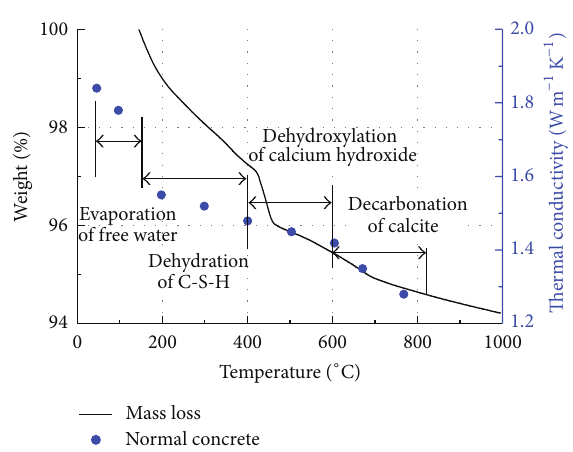
Figure 6: Results of thermogravimetric analysis and thermal con- ductivity values for normal concrete with